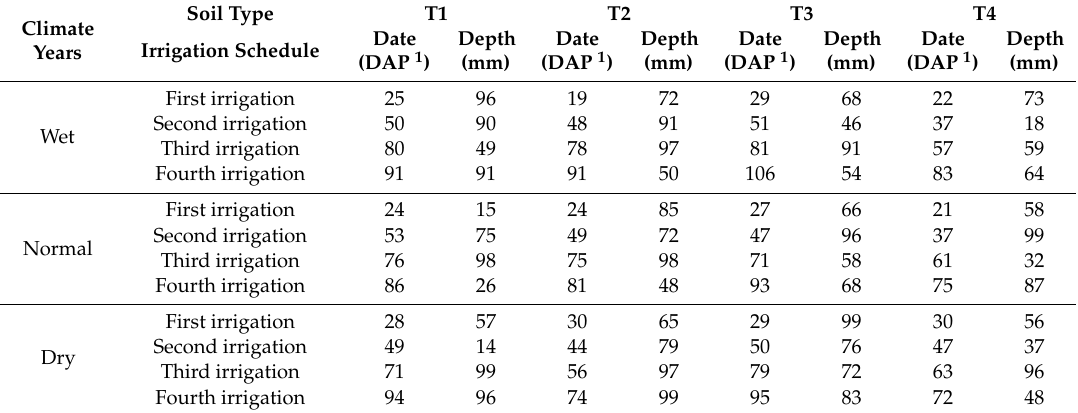
Table 4. Optimal irrigation schedules under di ff erent soil types in Danman Irrigation District under di ff erent climate